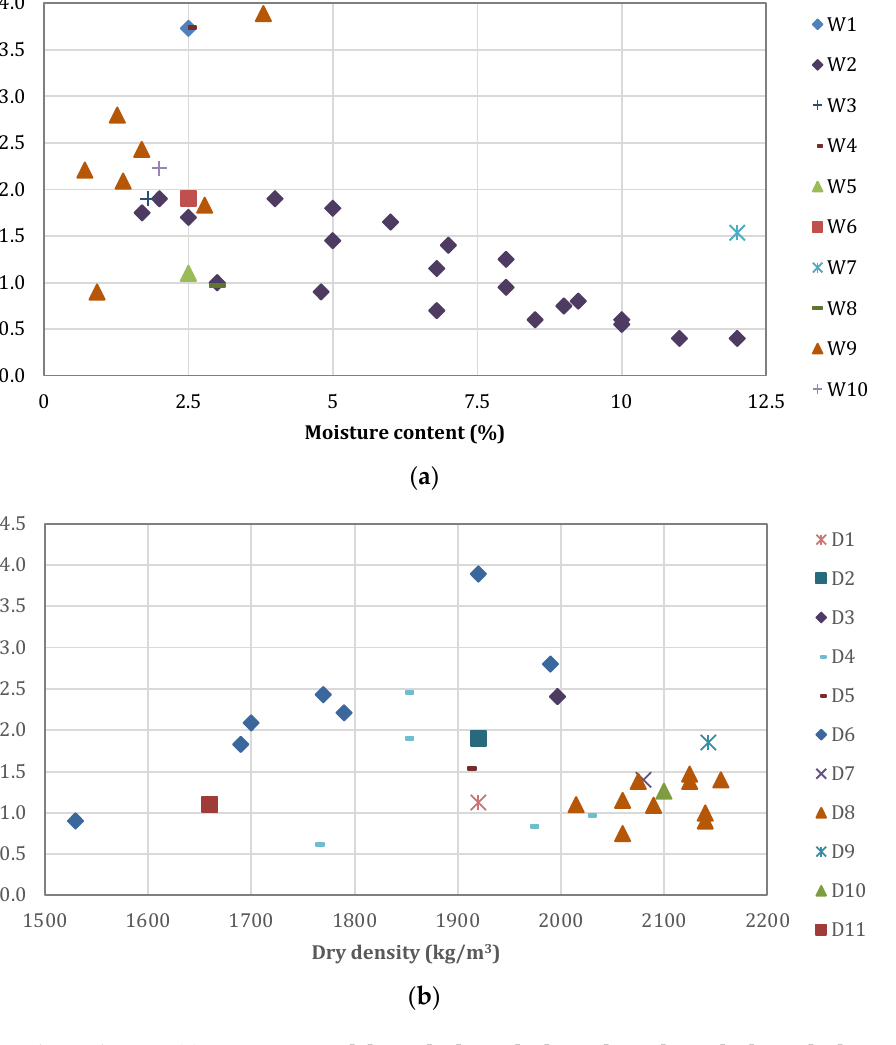
Figure 2. UCS value depending on ( a ) moisture: W1 [1], W2 [20], W3 [21], W4 [26,54], W5 [39], W6 [55], W7 [56], W8 [57], W9 [58], W10 [59]; and ( b ) dry density: D1 [20], D2 [21], D3 [49], D4 [51], D5 [56], D6 [58], D7 [60], D8 [61], D9 [62], D10 [63], D11